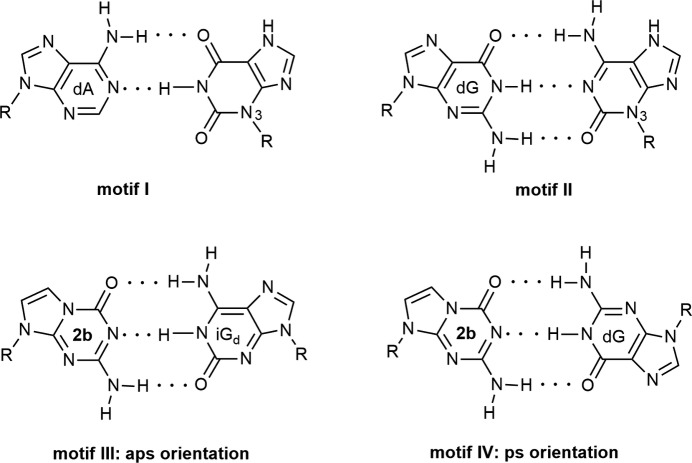
Upper row: ‘all-purine’ pairs suggested by Wächtershäuser (1988 ▸). Lower row: purine–purine base pairing motifs of 5-aza-7-de­aza­guanine 2′-de­oxyribonucleoside (2b) with anti­parallel (aps) or parallel (ps) strand orientation (Seela et al., 2001 ▸). Notes: iGd = 2′-de­oxy­isoguanosine, dG = 2′-de­oxy­guanosine and R = β-d-2′-de­oxy­ribo­furanosyl.